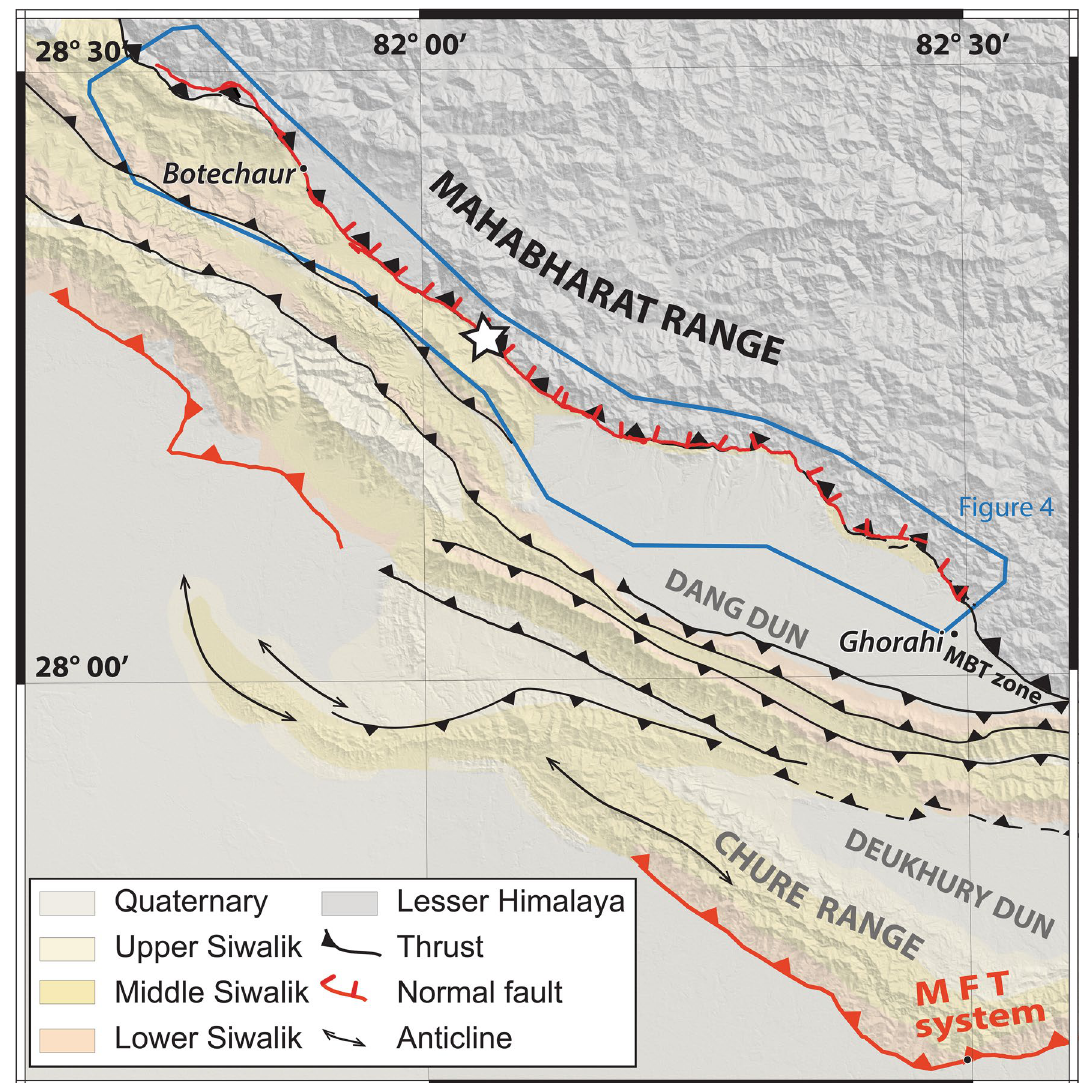
Figure 2. Regional structural and geological map of the frontal Himalayan thrust system in western Nepal compiled from Dhital 19 ; Mugnier et al. 41 ; the Geological exploration map of Nepal by the Petroleum Exploration Promotion Project of the Department of Mines and Geology, Nepal and mapping from satellite images. Frame located on Fig. 1. Blue box locates our high-resolution Pléiades images Fig. 4. The Surkhet-Gorahi segment of the Reactivated Boundary Fault (reactivated Main Boundary Thrust) is represented by red lines. MFT: Main Frontal Thrust. (1) Highlights the Sukhetal site where a pit and a trench were excavated. Dang and Deukhury Dun are piggy-back basins. Figure generated with ENVI Classic (https:// www. l3har risge ospat ial. com/ Softw are- Techn ology/ ENVI) and Adobe illustrator CS6 (http:// www. adobe. com/ fr/ produ cts/ illus trator.